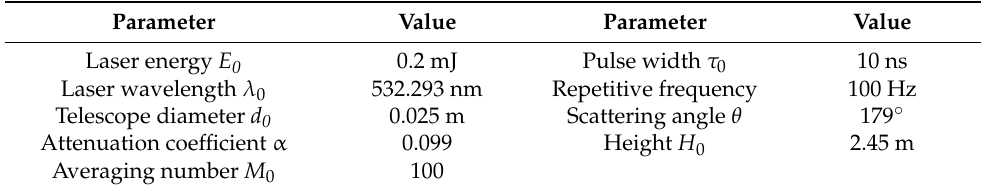
Table 2. Parameters of the Brillouin energy measurement system.